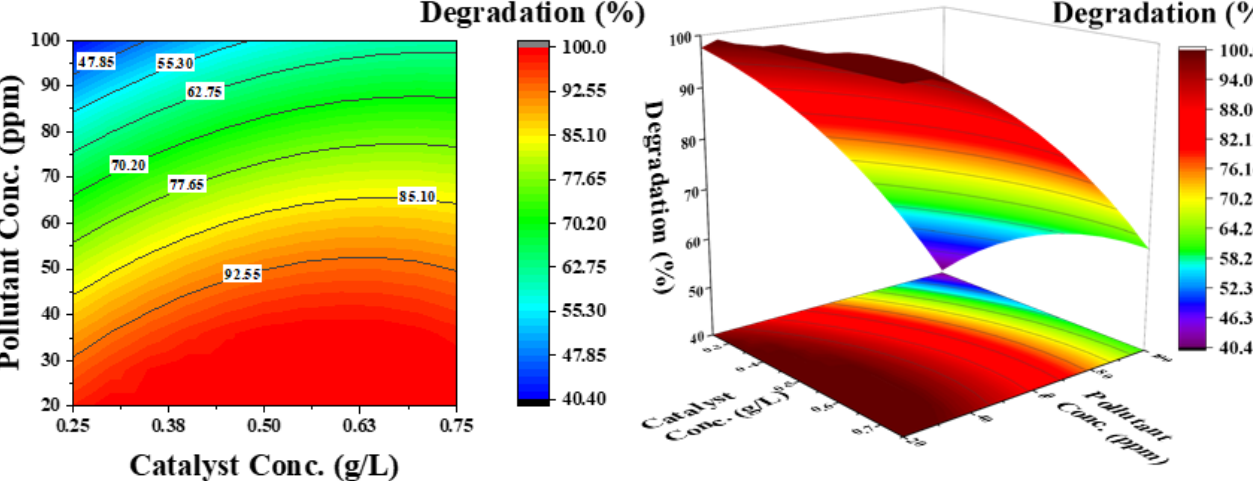
Figure 9. Effect of catalyst concentration and pollutant concentration on the degradation of phenol: pH was kept constant at 6.5.